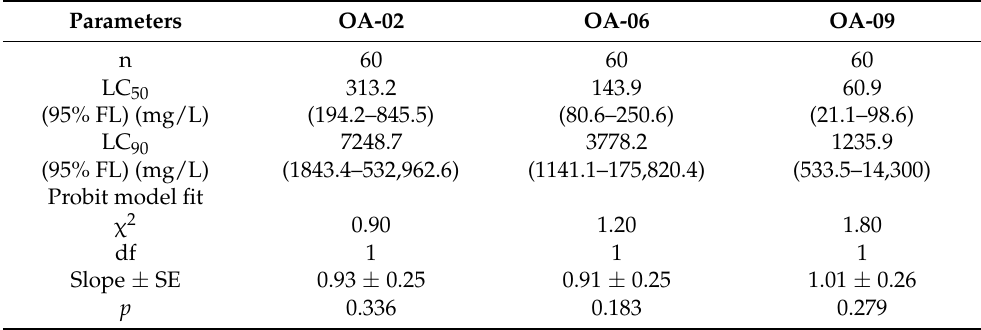
Table 3. LC50 and LC90 values of OA-02, OA-06 and OA-09 compounds against H. armigera larvae along with their probit model fit